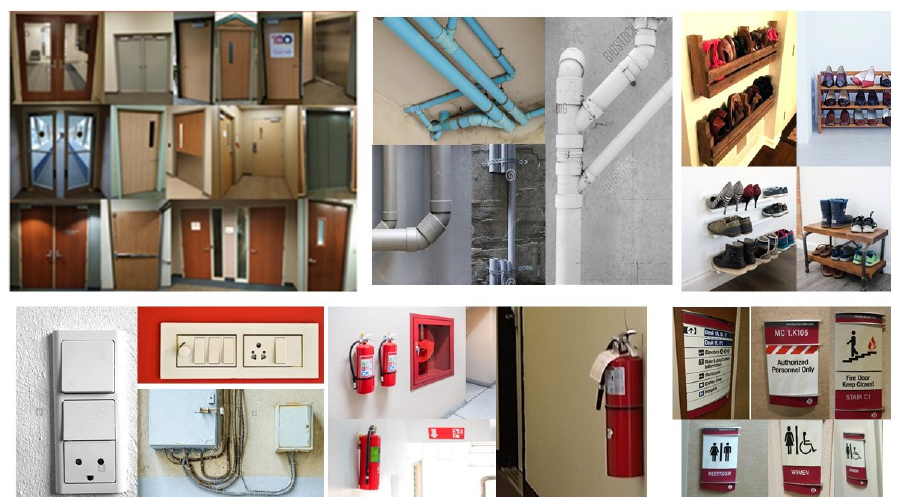
Figure 11. Training data set for wall/floor segmentation.